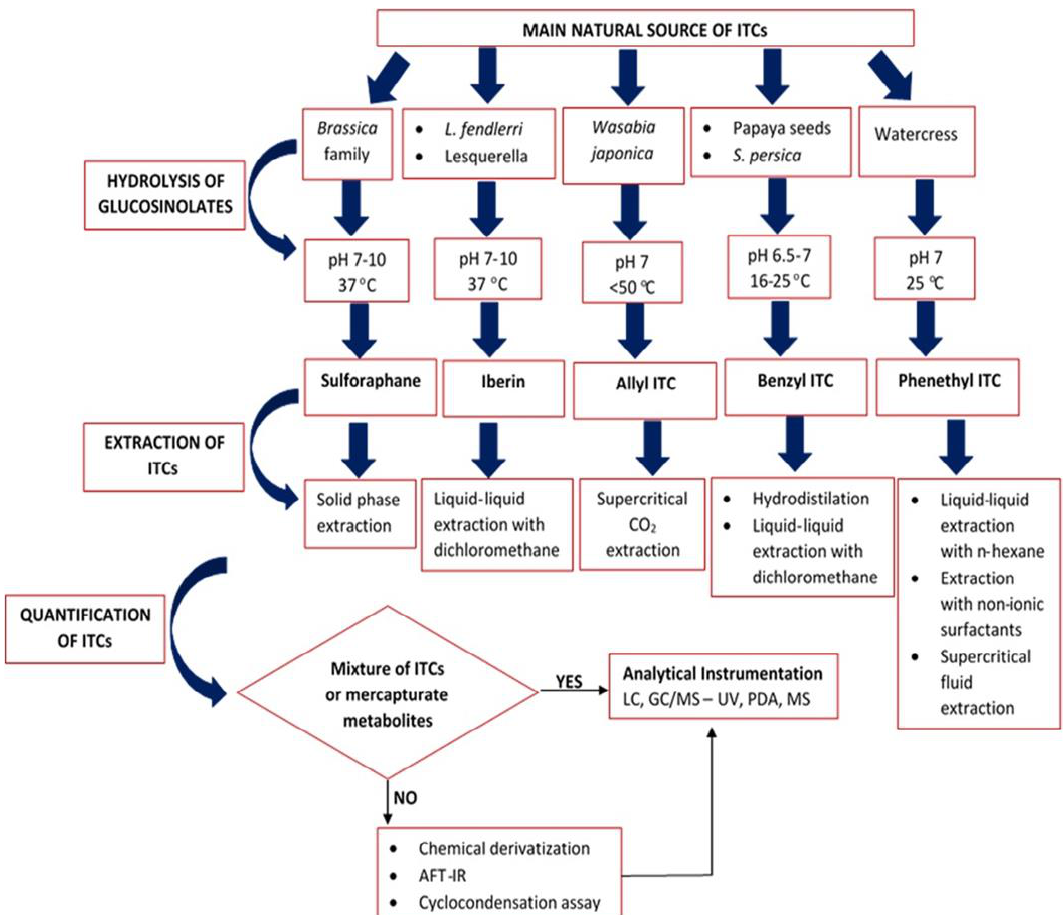
Figure 5. Graphical presentation of the proposed methodological pipelines for the determination of ITCs from various natural sources, taking into consideration the efficacy of each approach based on recovery yield of isolated ITCs.